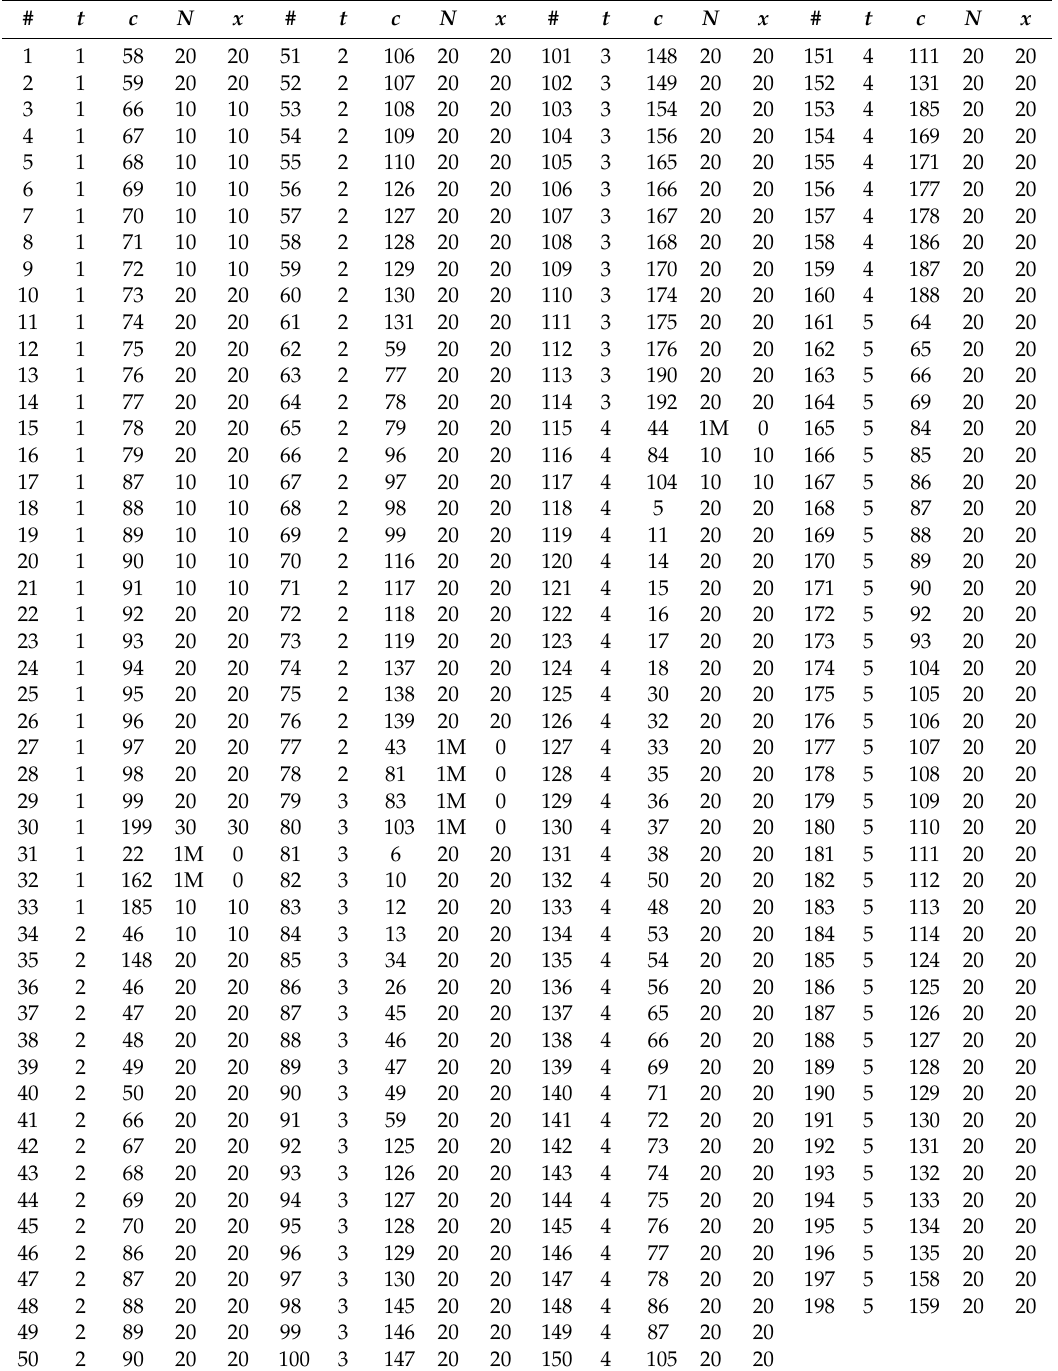
Table 5. The 198 high-level data points for the laser welding